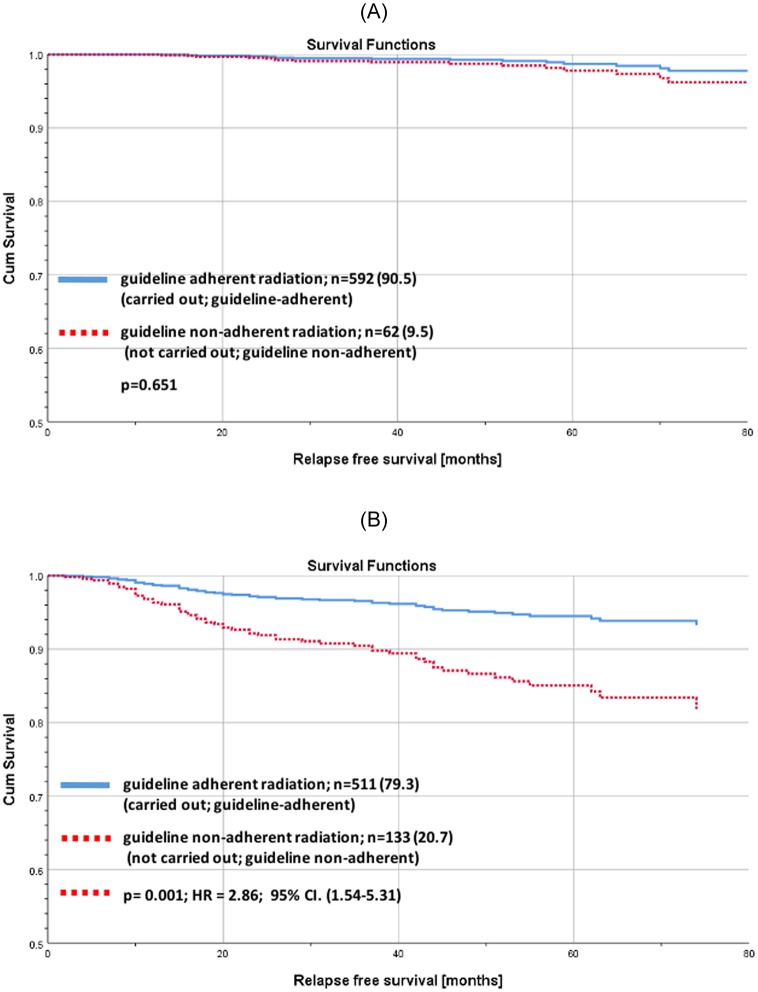
Cox regression of recurrence free survival for early breast cancer patients aged ≥ 70 years adjusted by adjuvant systemic therapy (AST) and physical status.(A) Cox regression of recurrence free survival for low risk early breast cancer patients aged 70 years or older with guideline adherent BCS stratified by guideline adherent RT and adjusted by adjuvant systemic therapy (AST), ASA physical status classification system and the New York Heart Association (NYHA) functional classification. Low risk: luminal A and T1/T2 and node-negative. (B) Cox regression of recurrence free survival for higher-risk early breast cancer patients aged 70 years or older with guideline adherent BCS stratified by guideline adherent RT and adjusted by adjuvant systemic therapy (AST), ASA physical status classification system and the New York Heart Association (NYHA) functional classification. Higher-risk: other than luminal A or G3 or T3/T4 or node-positive.